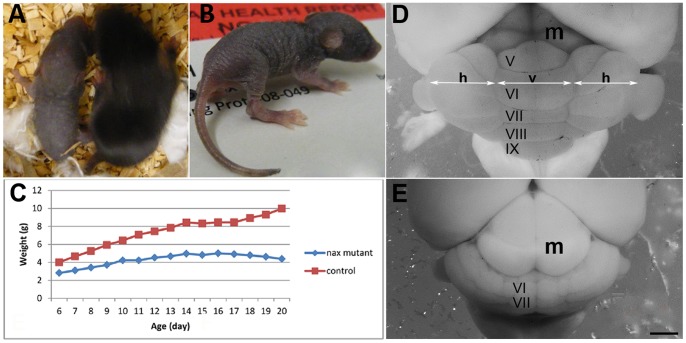
Physical description of the nax mutant mouse.
A–B) nax mutant and wild type sibling at P10. The nax mutant is characterized by lack of hair over the entire body and a smaller stature compared to the wild type sibling. C) Growth curve of nax mutant mice in comparison with wild type siblings showing severe growth retardation during postnatal development. D–E) Dorsal view of wild type sibling (D) and nax mutant (E) cerebella at P19. (D) The wild type cerebellum developed normally with a lobulated vermis (v; middle arrow) in the middle and hemispheres (h; arrow in each side) on each side. (E) An underdeveloped vermis is prominent in the small cerebellum of the nax mutant and the boundary between the vermis and each hemisphere is not obvious. The midbrain (m) can clearly be seen from the dorsal aspect due to the small cerebellum. Individual lobules in the vermis are indicated in Roman numerals. Scale bar: E = 1 mm (D, E).